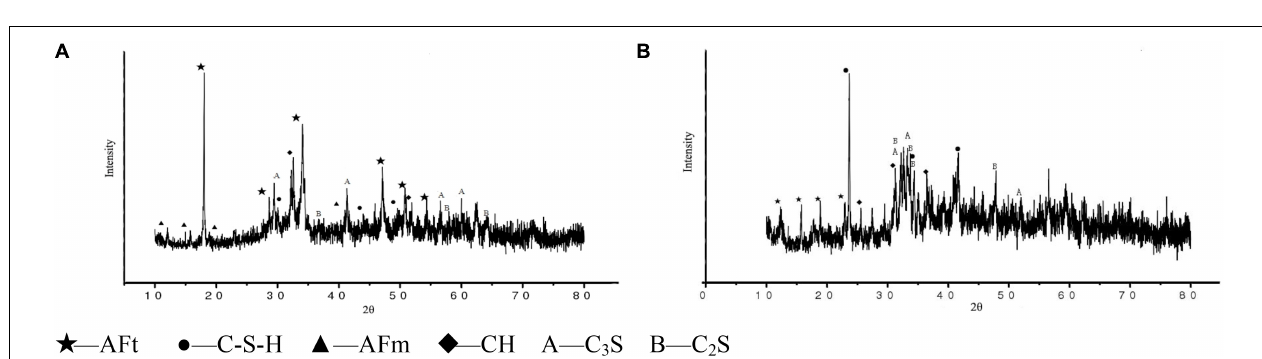
FIGURE 6 | (A) Microstructure of CAEM at 2 h. (B) Microstructure of CAEM at 28 days.